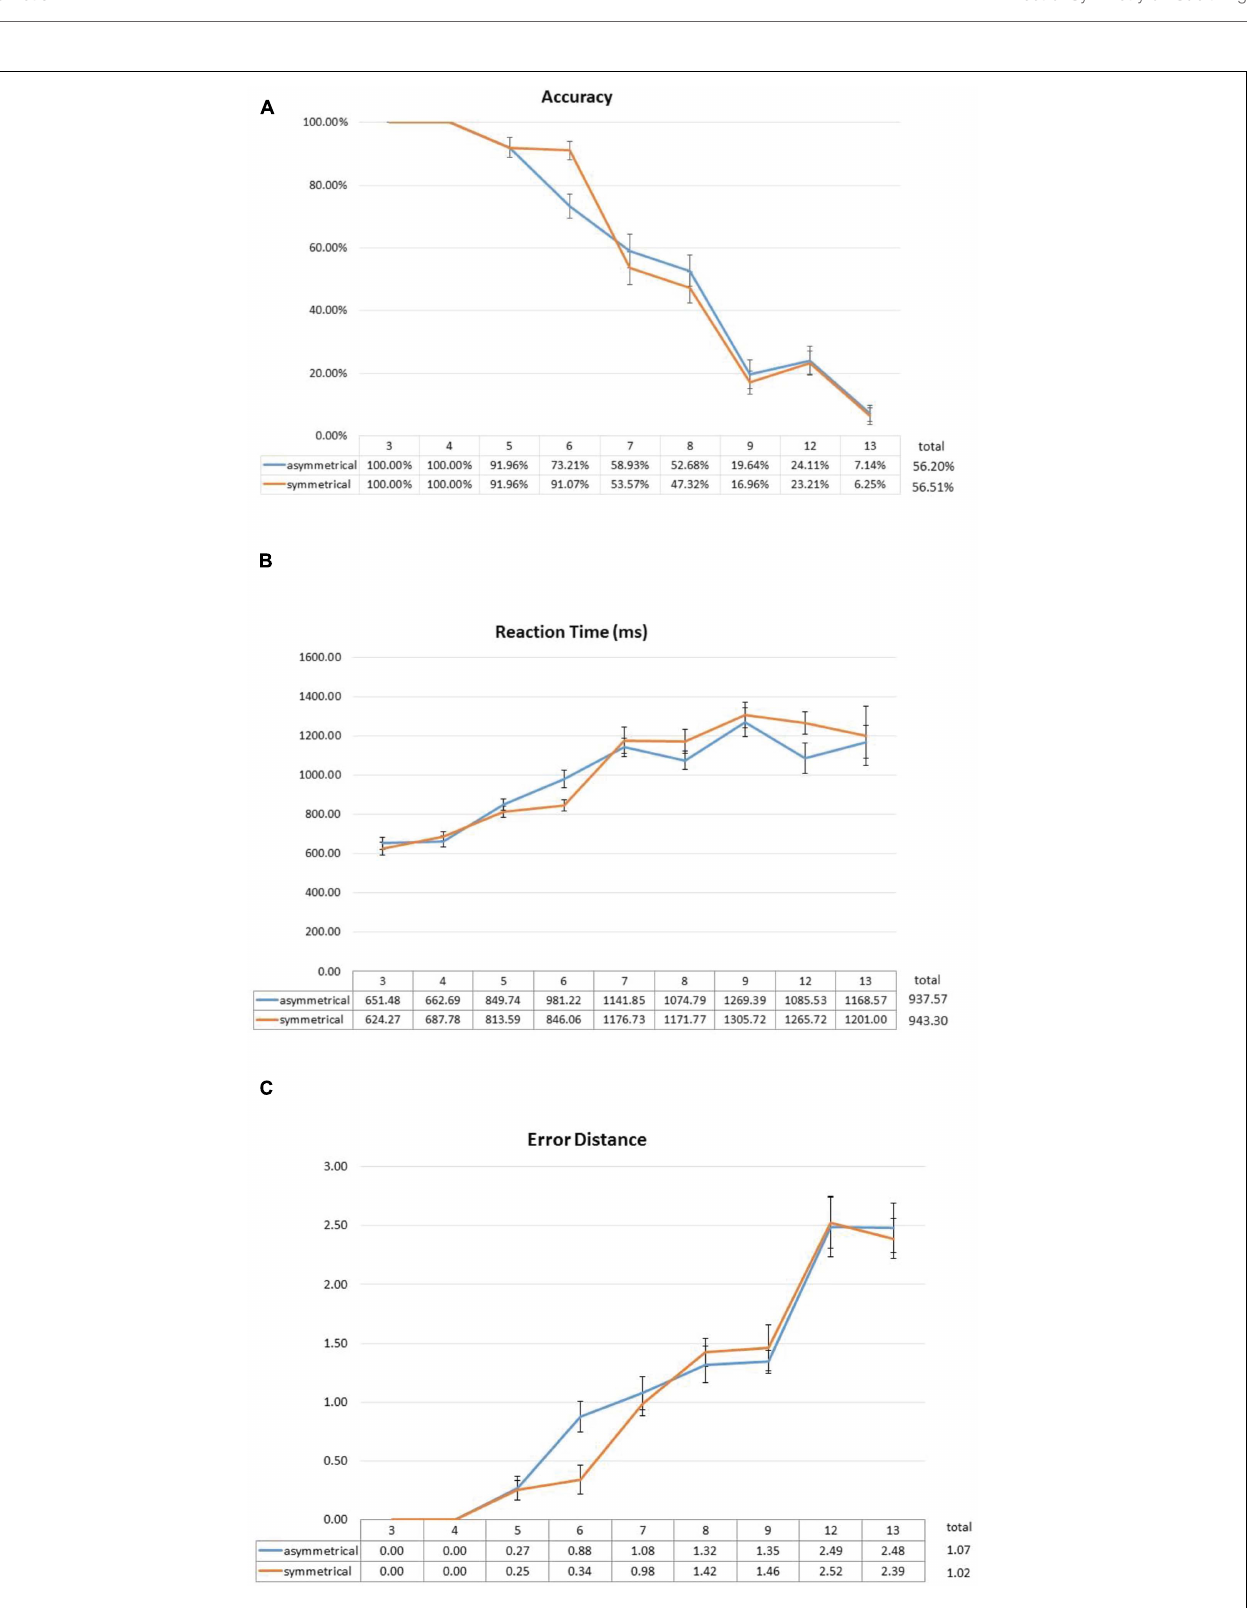
FIGURE 4 | Effect of symmetrical structure on subitizing accuracy (A) , RT (B) , and error distance (C) . The significant interaction in accuracy was mainly driven by the 20% difference at set size 6. Similar effects were also observed in RT and error distance, albeit in much weaker forms. Error bars represent standard error of the